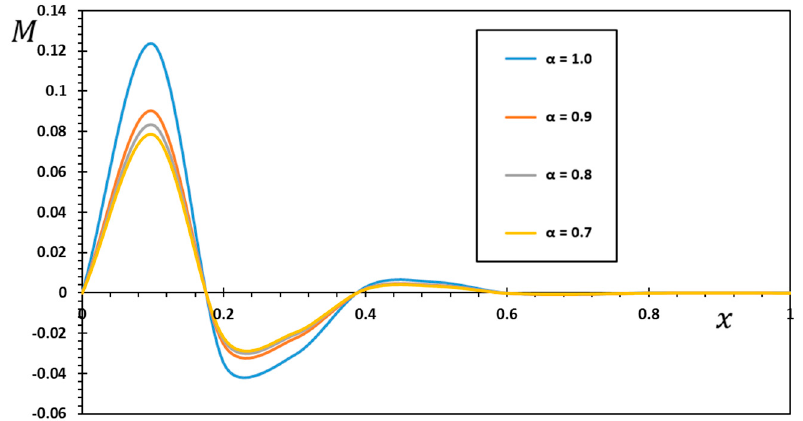
Figure 5. Effect of fractional order, 𝜶 , on the bending moment, 𝑴 .